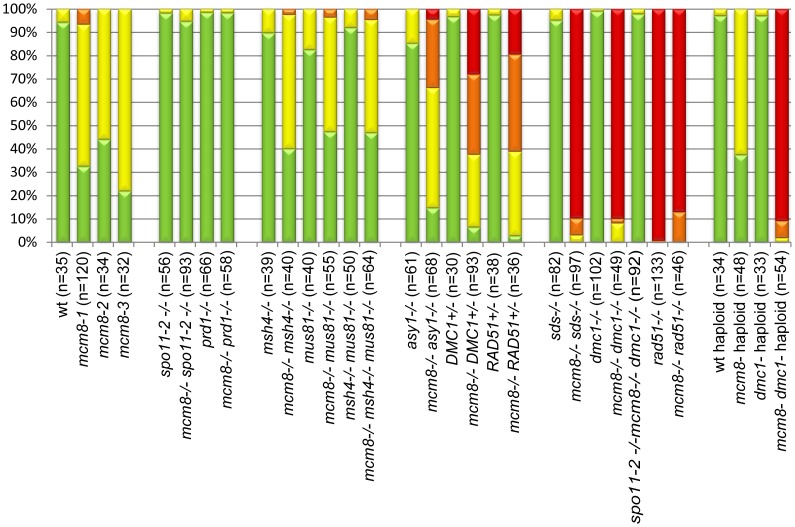
Quantification of chromosome fragmentation levels.For each genotype, a number (indicated in brackets) of late anaphase I/telophase I cells were observed after chromosome spreads and DAPI staining. DAPI-stained bodies observed above the expected number of chromosomes were counted as fragments, and cells were classified has having 0 (green), 1–5 (yellow), 6–10 (orange), or more than 10 fragments (red). The percentage of each class is shown.